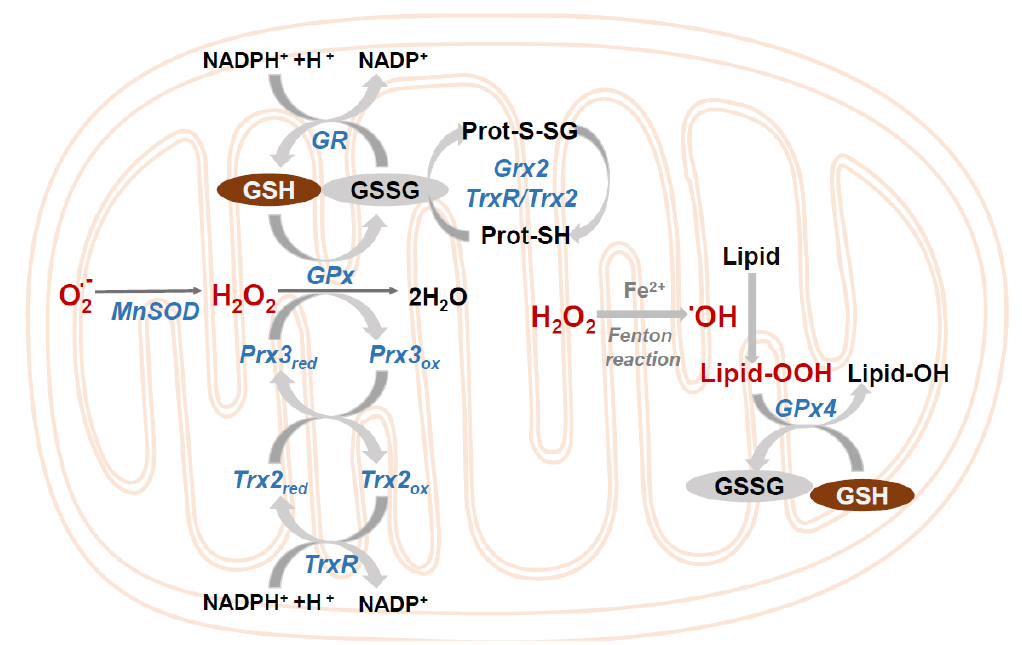
Figure 3. Mitochondrial control of ROS. Different reactions that take place in the mitochondria to eliminate superoxide and hydrogen peroxide. GSH peroxidase (GPx); GSSG-reductase (GR); GSSG, glutaredoxin-2 (Grx2); Mn-dependent superoxide dismutase (MnSOD); thioredoxin-2 (Trx2); Trx-reductase (TrxR); peroxiredoxin-4 (Prx3). mGSH together with the thioredoxin system, in particular mitochondrial thioredoxin 2 / thioredoxin reductase 2 (Trx2 / TrxR2), maintain thiol redox status within mitochondria [32]. In